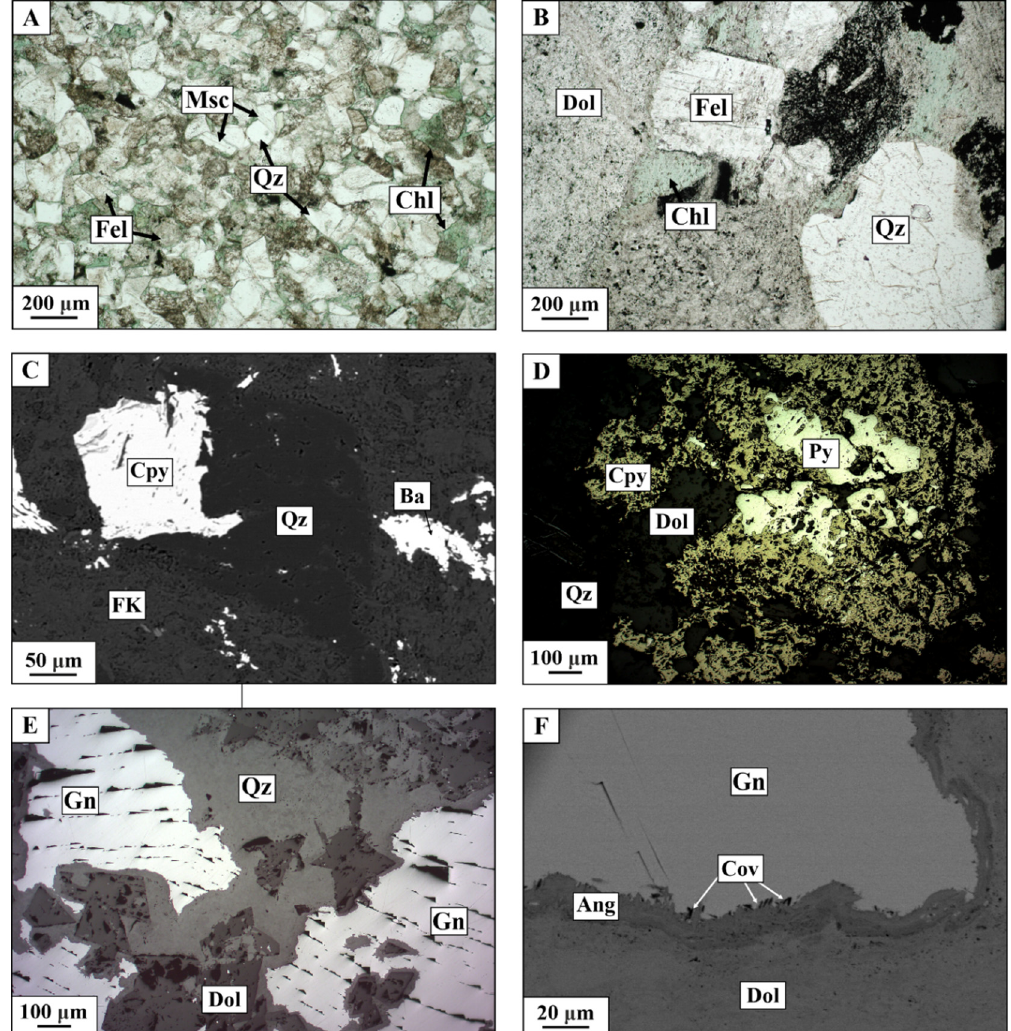
Figure 5. Representative samples and observations of the host rocks: transmitted polarized light microphotographs ( a , b ), SEM microphotographs in backscattered electrons mode ( c , f ) and reflected polarized light microphotographs ( d , e ). ( a ) Abundance of chlorite (Chl—chlorite; Qz—quartz; Msc— muscovite; Fel—feldspar) in light-grey sandstone (TIZ 44); ( b ) Red sandstone (TIZ 41); ( c ) Chalcopyrite (Cpy) and barite (Ba) in coarse grey sandstone (TIZ S19); ( d ) Pyrite (Py) and chalcopyrite in Basal Conglomerate (TIZ S10); ( e ) Galena (Gn) in the Tamjout Dolomite (TIZ 45); ( f ) Galena, covellite (Cov) sticks and anglesite (Ang) in the Tamjout Dolomite (TIZ 45).